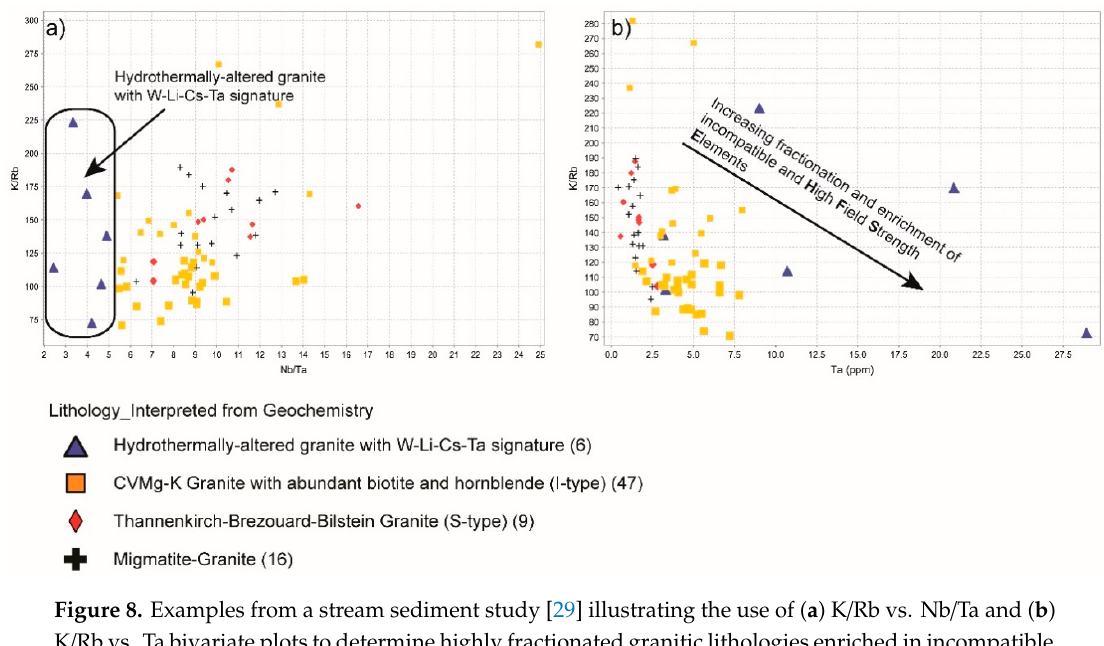
Figure 8. Examples from a stream sediment study [29] illustrating the use of ( a ) K/Rb vs. Nb/Ta and ( b ) K/Rb vs. Ta bivariate plots to determine highly fractionated granitic lithologies enriched in incompatible elements. In the central Vosges Mountains (France), peraluminous melts affected by hydrothermal alteration are thought to occur within a larger I-type granite province. In stream sediment samples, hydrothermally-altered granites are characterised by 70 < K/Rb < 225 and Nb/Ta < 5.